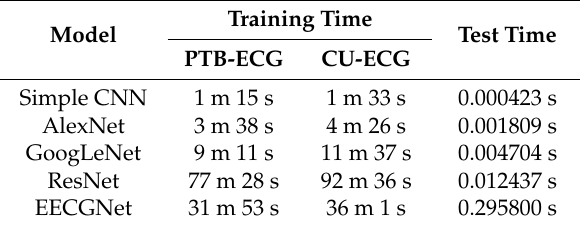
Table 11. Comparison of computational time.